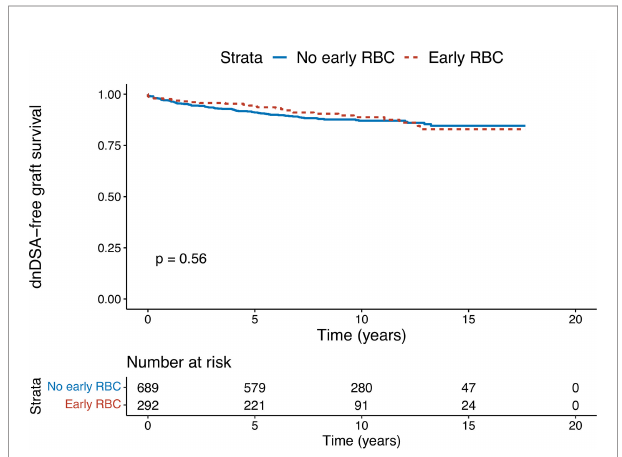
FIGURE 1 | Kaplan – Meier survival analysis of early (within 3 months post- transplantation) red blood-cell transfusion on dnDSA-free graft survival. The given p-value stands for the log-rank